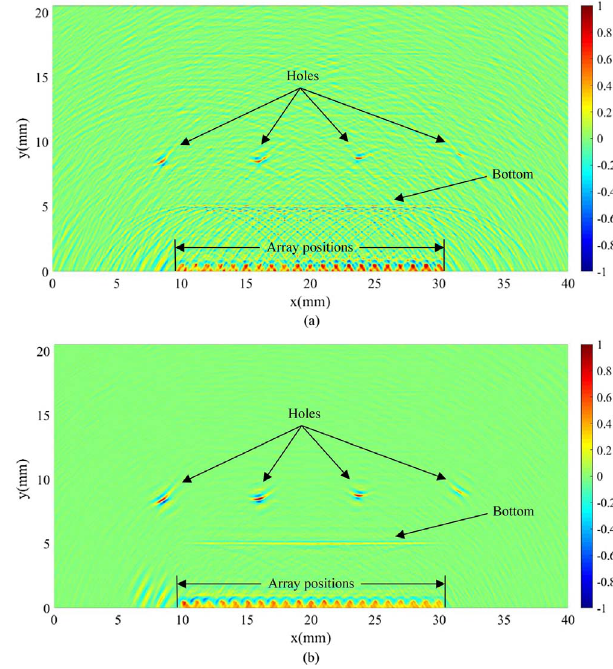
Figure 8. (a) The image of SAFT using the same data as B-scan. (b) The image of FMC/TFM